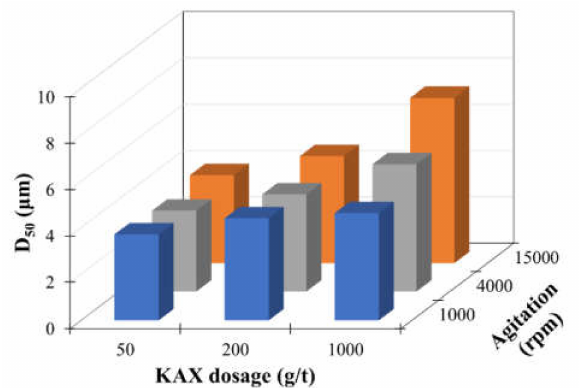
Figure 7. E ff ects of KAX dosage and agitation speed on the median diameter (D 50 ) of agglomerates (Kerosene 15 L kerosene / t sample).